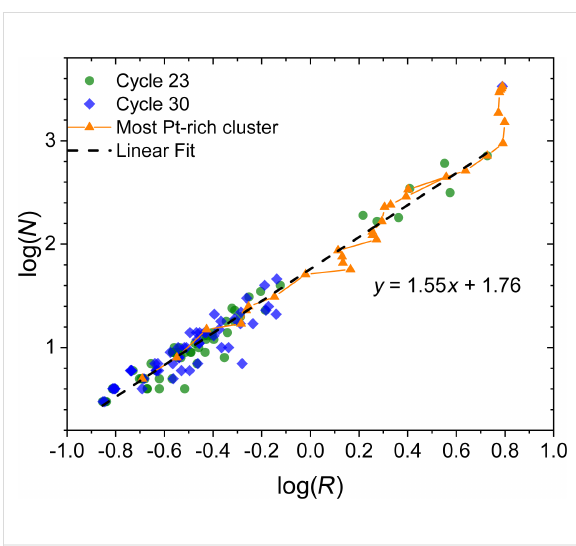
Figure 9: Double-log plot of the number of Pt atoms N in the deposited clusters as function of the radius R of the circumscribed sphere. Green dots and blue diamonds correspond to the whole ensemble of deposits at the end of the 23rd and 30th simulation cycle, respectively. Intercon- nected orange triangles describe the cycle-by-cycle growth of the most Pt-rich clusters. The dashed line shows a linear fit of the log( N )-vs- log( R ) distribution of the clusters at the end of the 23rd simulation cycle.